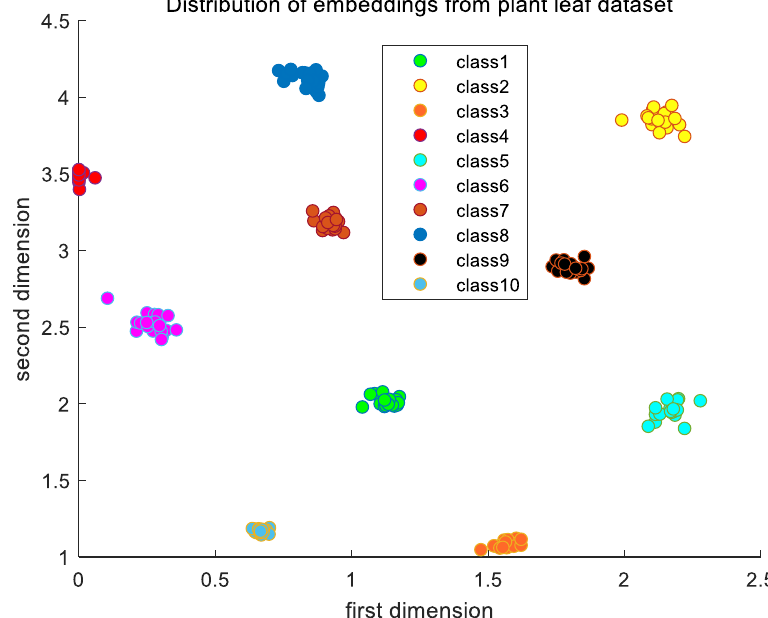
Figure 11. The distribution of embeddings from the plant leaf dataset.